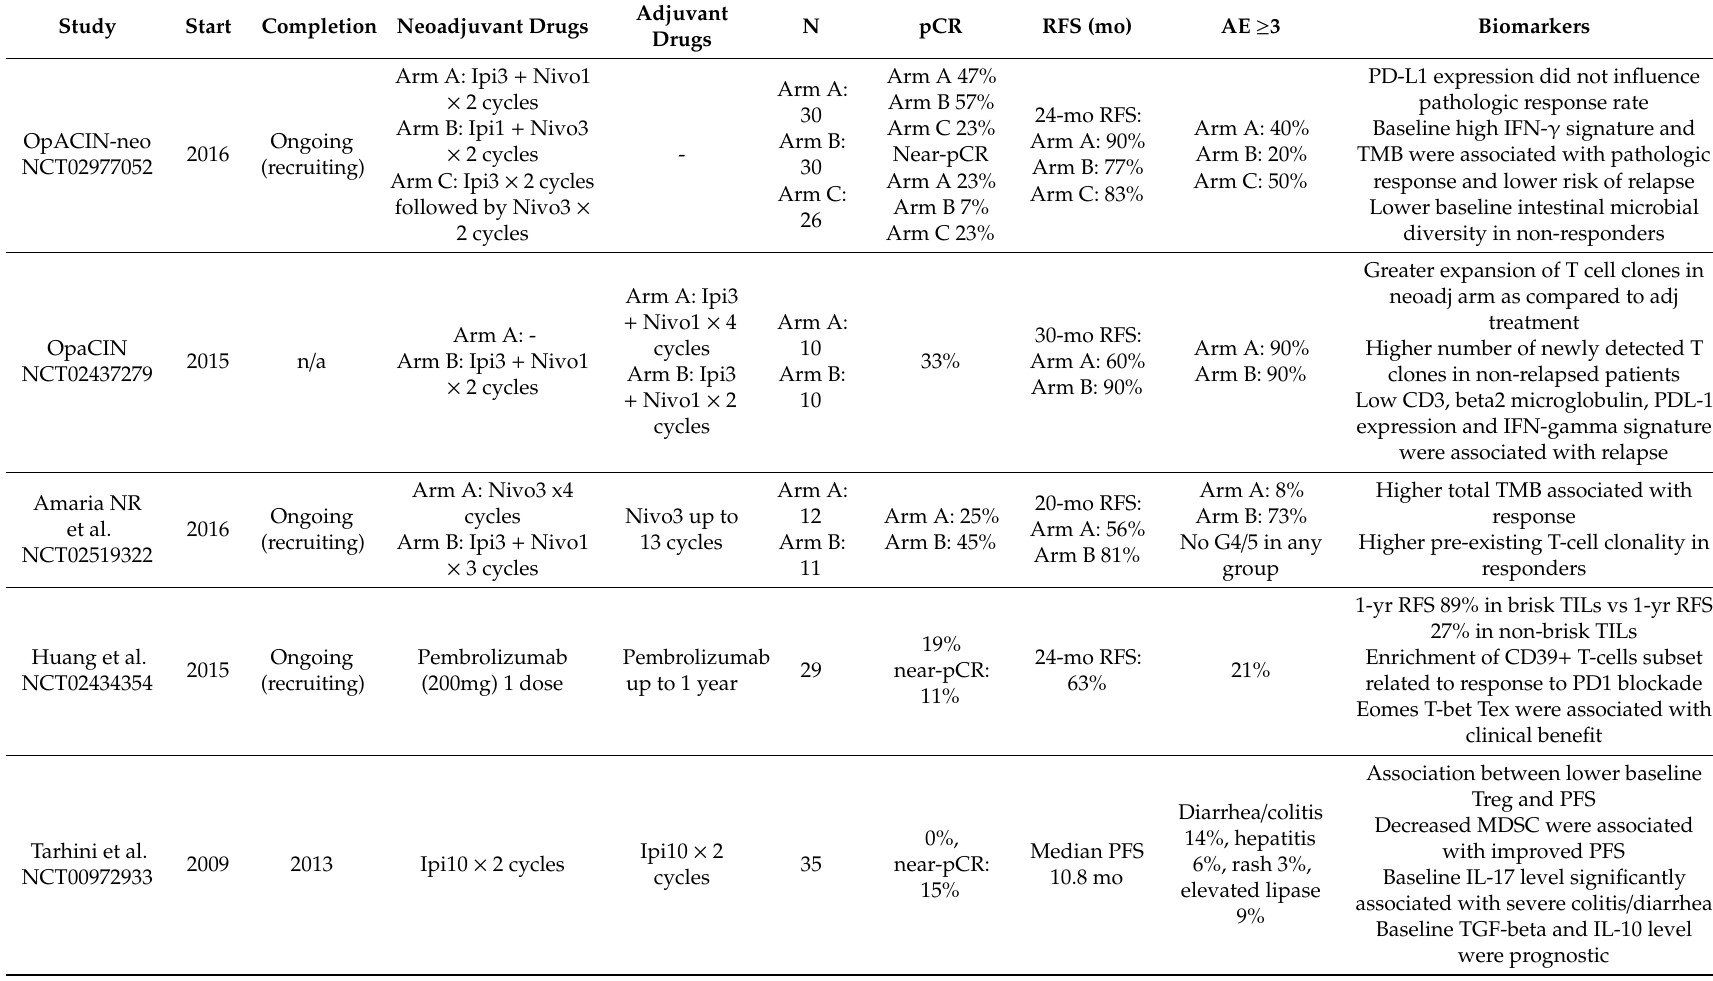
Table 1. Key neoadjuvant trials for stage III